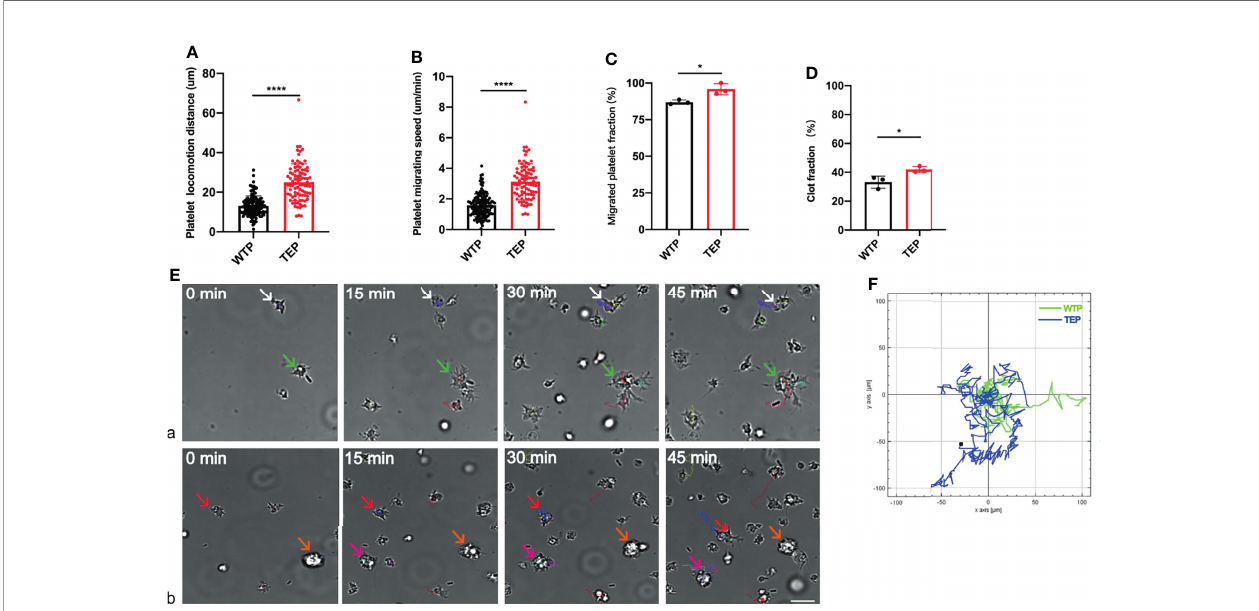
FIGURE 1 | Platelet locomotion assay. (A) TEPs could migrate longer; (B) TEPs could migrate faster than the control group; (C) TEPs were eager to migrate; (D) TEPs were more ef fi cient to form clots; (Ea) the WTP can migrate to contact with each other (white and green arrows); (Eb) TEPs can migrate to form clots (red and pink arrows), and some clots are formed before they attached to the substrate (orange arrows). Different colors are used to mark different platelet tracks. The scale bars represent 7 m m; (F) chemotaxis migration analysis data showed that TEPs achieved a longer track (blue) in relative to WTPs (green); n = 3 experiments; mean ± SEM; Students-t and